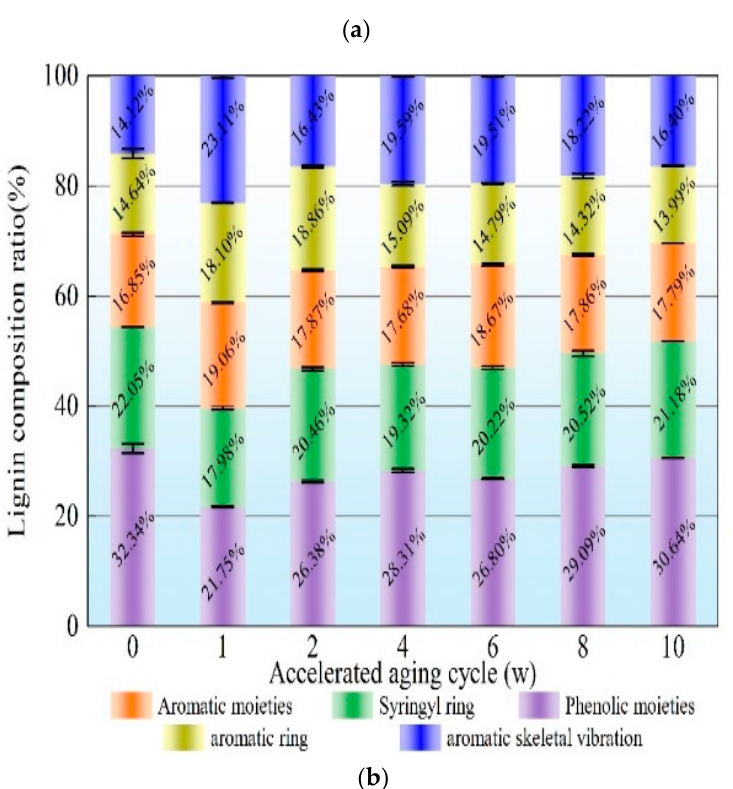
Figure 8. Fourier infrared spectra of bamboo during humidity and heat ageing. ( a ) Chemical composition of cellulose and hemicellulose functional groups as a percentage ( b ) Chemical composition of lignin functional groups as a percentage. Table 5. Assignment of significant functionalities from FTIR spectra.